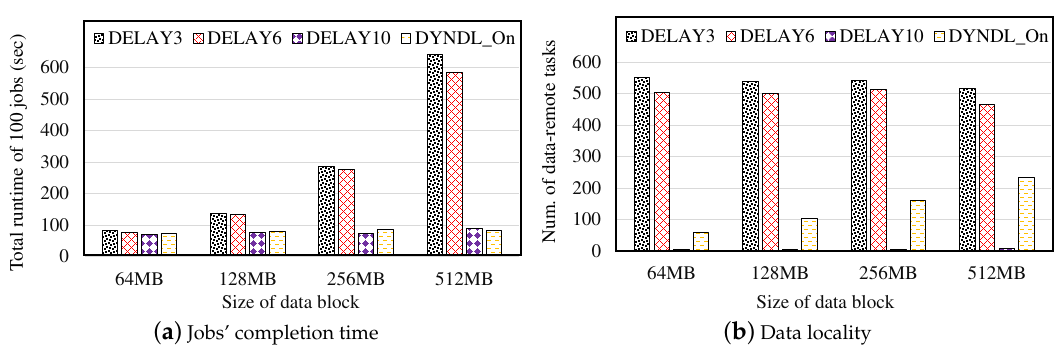
Figure 11. Results of running 100